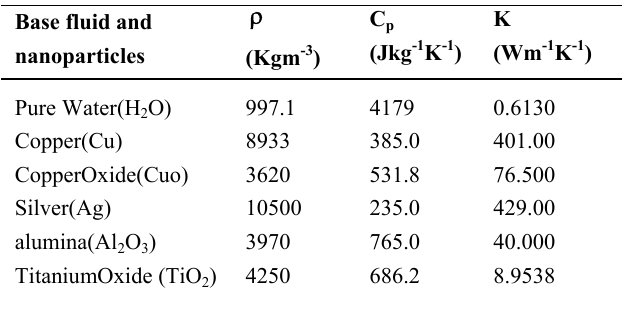
Table 1. Thermo-physical properties of water and nanoparticles.